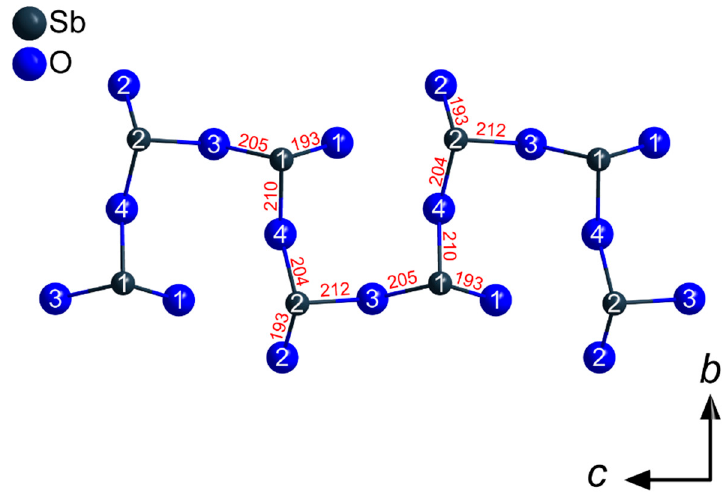
Figure 4. Network of vertex-connected [SbO 3 ] 3 ‒ ψ 1 -tetrahedra in the crystal structure of the Ln Sb 2 O 4 Br series ( Ln = Eu ‒ Tb) building up meandering strands of the composition {[SbO (cid:2870)/(cid:2870)(cid:3049) O (cid:2869)/(cid:2869)(cid:3047) (cid:2998)(cid:2869) ] – } along [001]. The given interatomic Sb ‒ O distances (in pm) are valid for TbSb 2 O 4 Br.